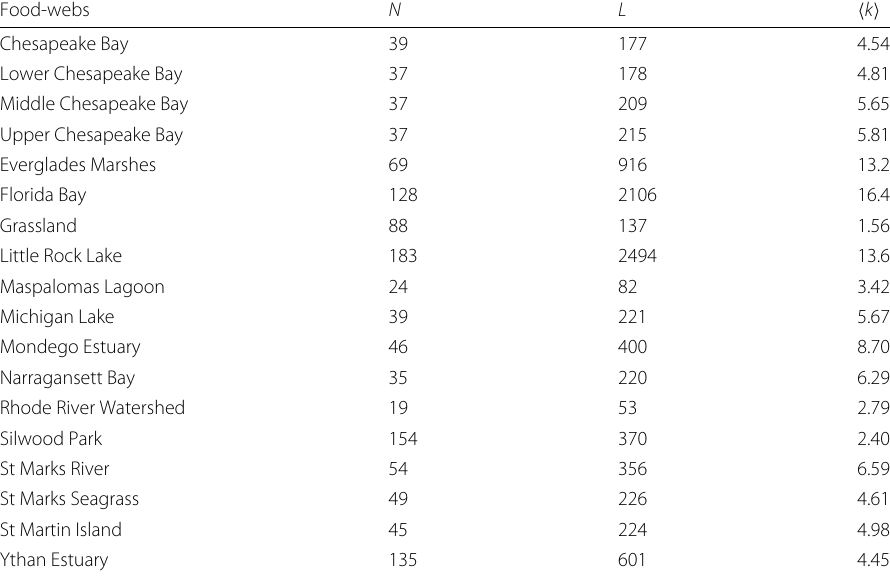
Table 2 Network statistics (number of nodes N , number of links L and average degree (cid:13) k (cid:14) for the directed version of 18 different food-webs (Squartini and Garlaschelli 2011)